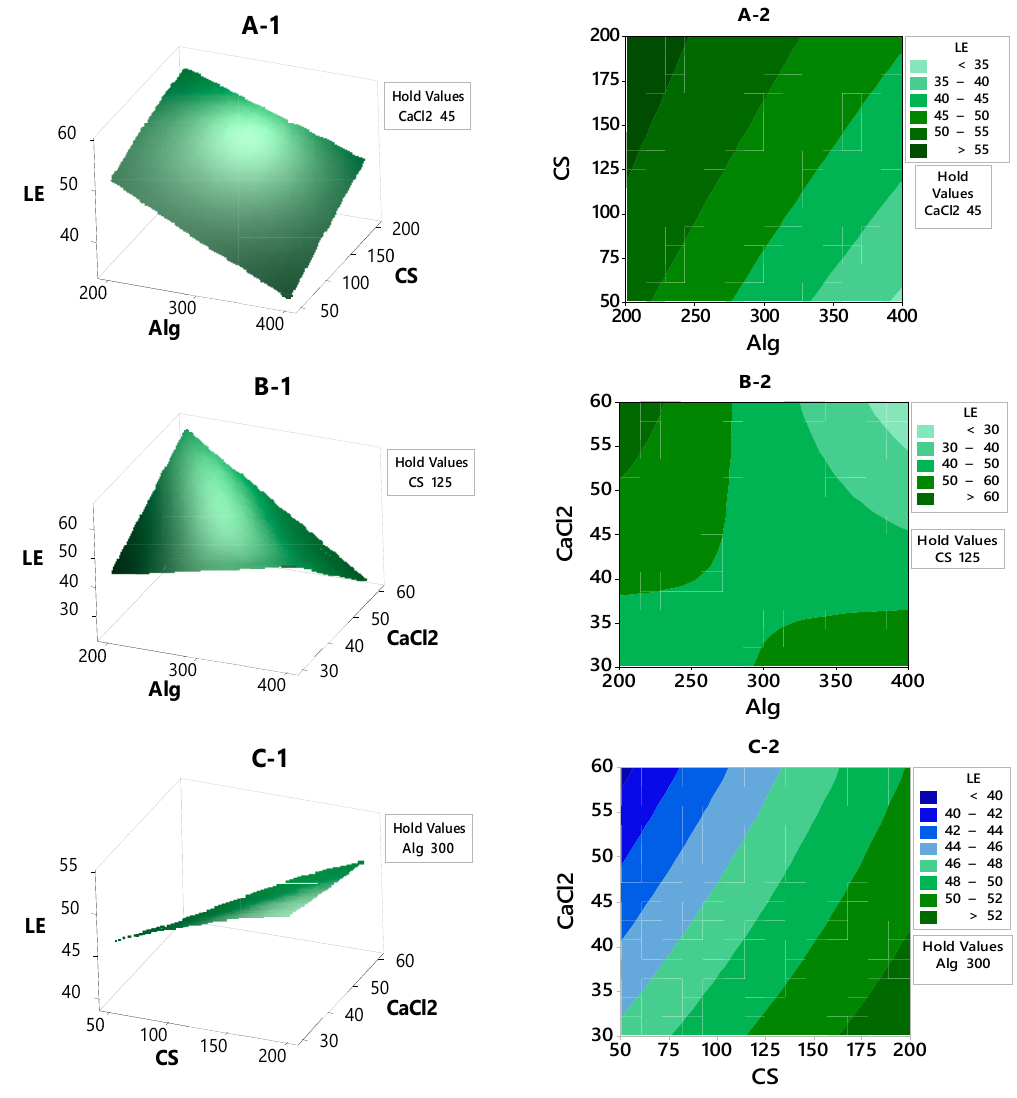
Figure 2. The contour plot and response surface of the LE with variances of CaCl 2 , Alg and CS concentrations.